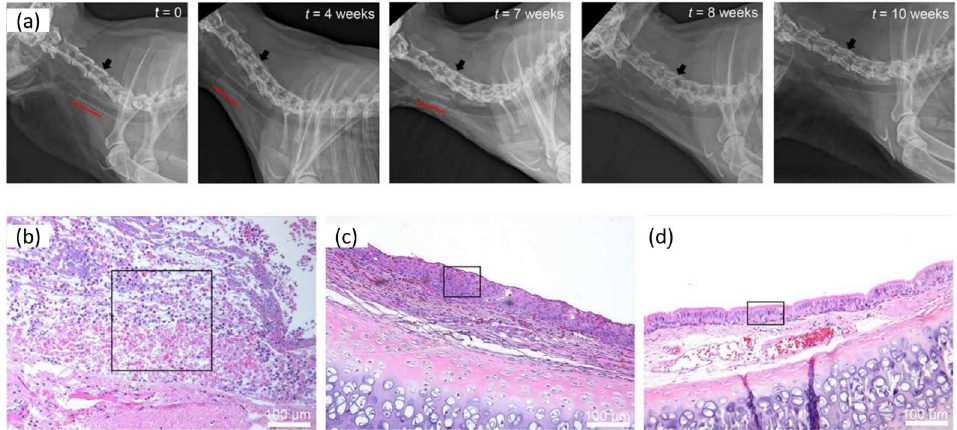
Figure 5. ( a ) Radiographs of a rabbit with the observation period of 10 weeks. Position of the stent is marked with a red line. Black arrows indicate the C4 vertebrae. ( b – d ) Inflammatory and tissue morphology changes in the rabbit’s trachea 2 ( b ), 6 ( c ), and 10 weeks ( d ) after the stent insertion. Black rectangles represent the parts of the main morphological changes over time including the area of inflammation and necrosis ( b ), squamous metaplastic epithelium ( c ), and pseudostratified columnar (respiratory) epithelium ( d ). Hematoxylin and eosin staining, magnification of 10 × 10. Reprinted with permission from [87].